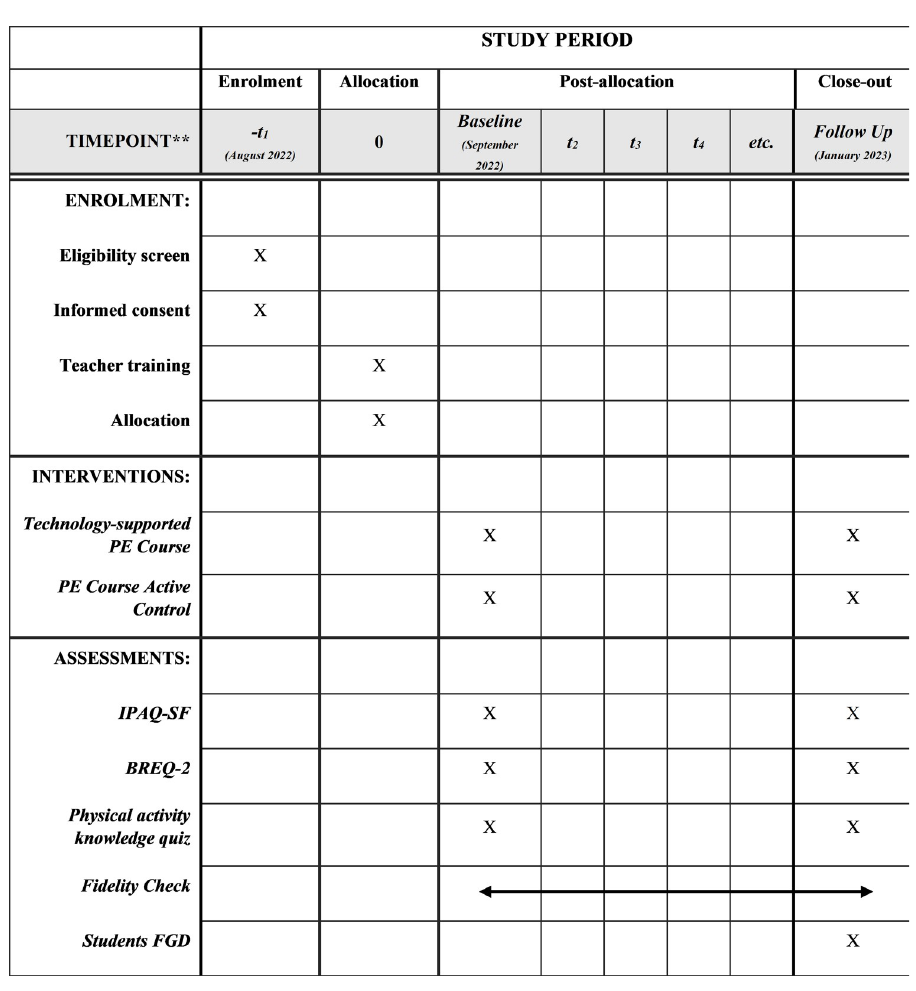
Fig 3. The SPIRIT schedule of enrolment, interventions, and assessments for the technology-supported physical education